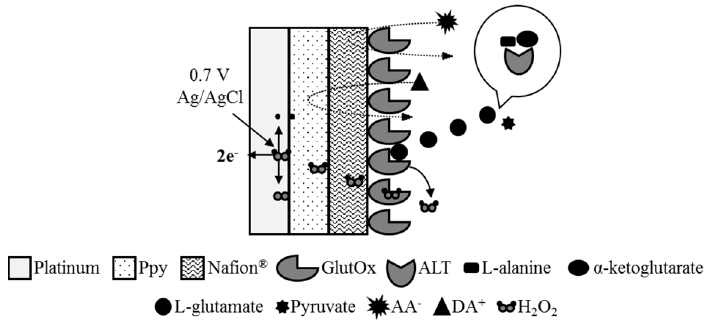
Figure 1. The schematic diagram showing the working principle of the ALT biosensor.